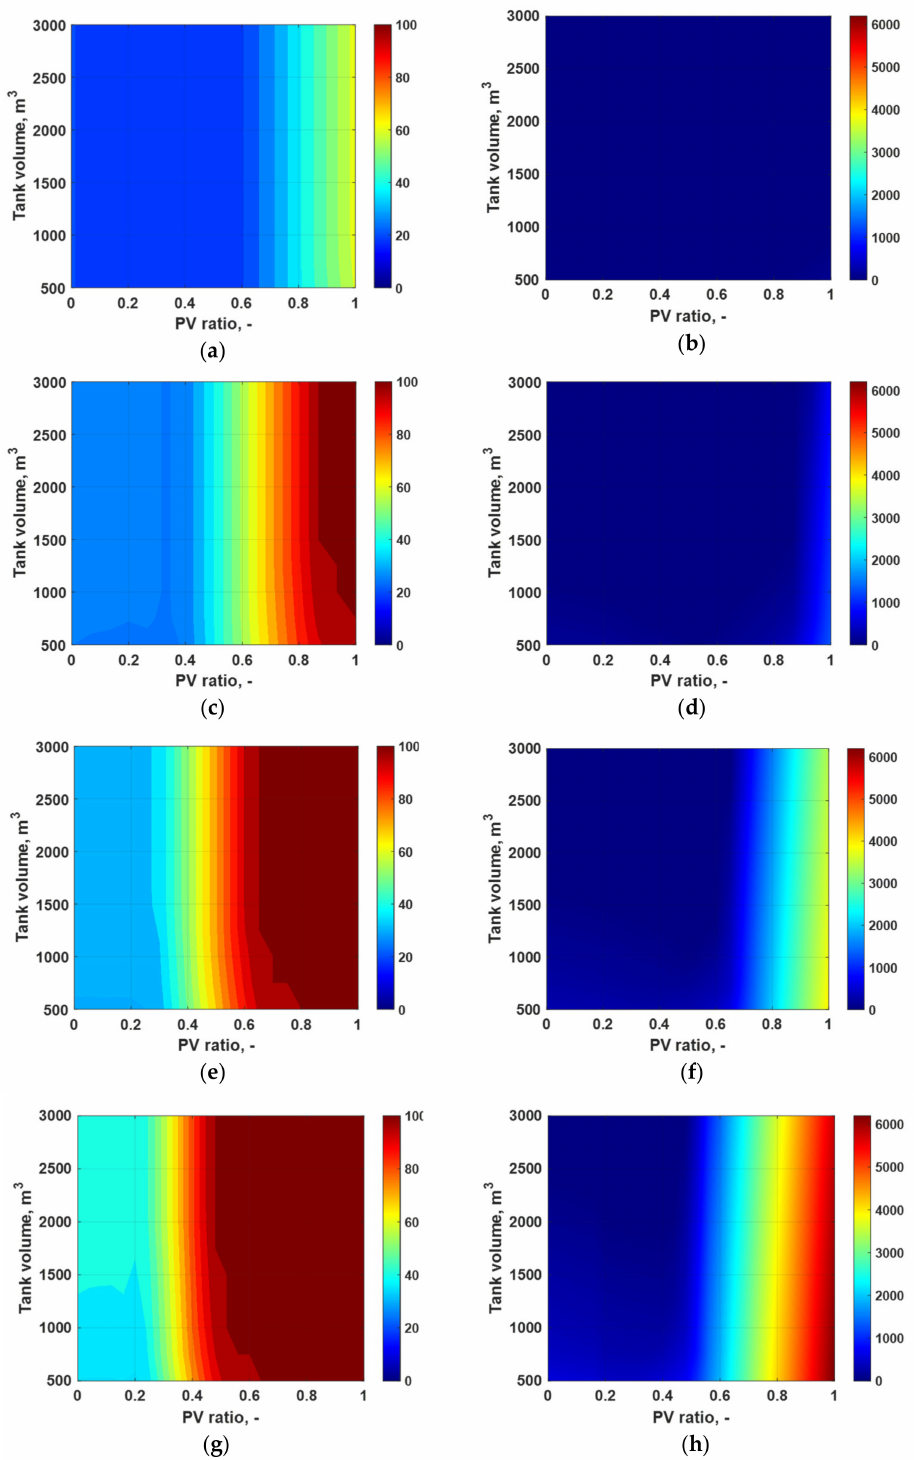
Figure 10. Variation of SCR (%) and WEE (kWh) for different hybrid systems for wine grapes in Suhindol with mSi PV panels and WT type 5: ( a ) SCR for 10kW HRES; ( b ) WEE for 10kW HRES; ( c ) SCR for 15kW HRES; ( d ) WEE for 15kW HRES; ( e ) SCR for 20kW HRES; ( f ) WEE for 20kW HRES; ( g ) SCR for 25kW HRES; ( h ) WEE for 25kW